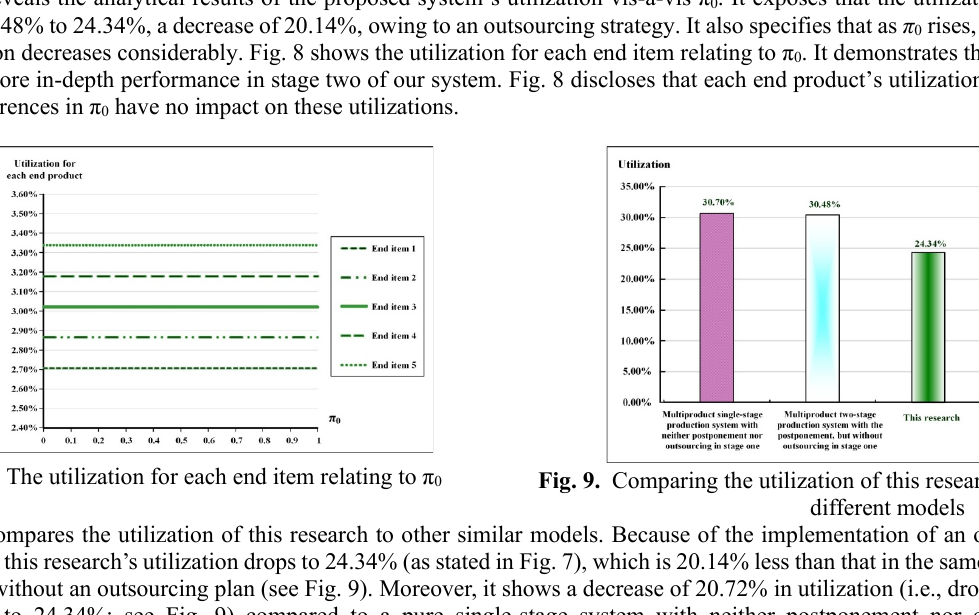
Fig. 6. The influence of variations in π 0 on stage one’s uptime t 0 *